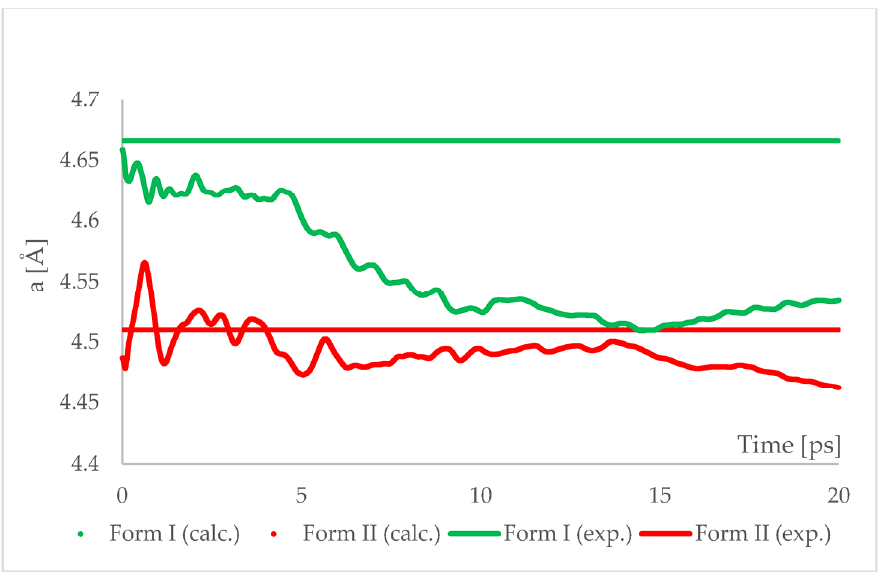
Figure 7. Running average of the unit cell edge length “a” obtained from aiMD simulation at T = 293 K and p = 6.2 GPa using PBE TS functional. Horizontal lines represent the experimental values.